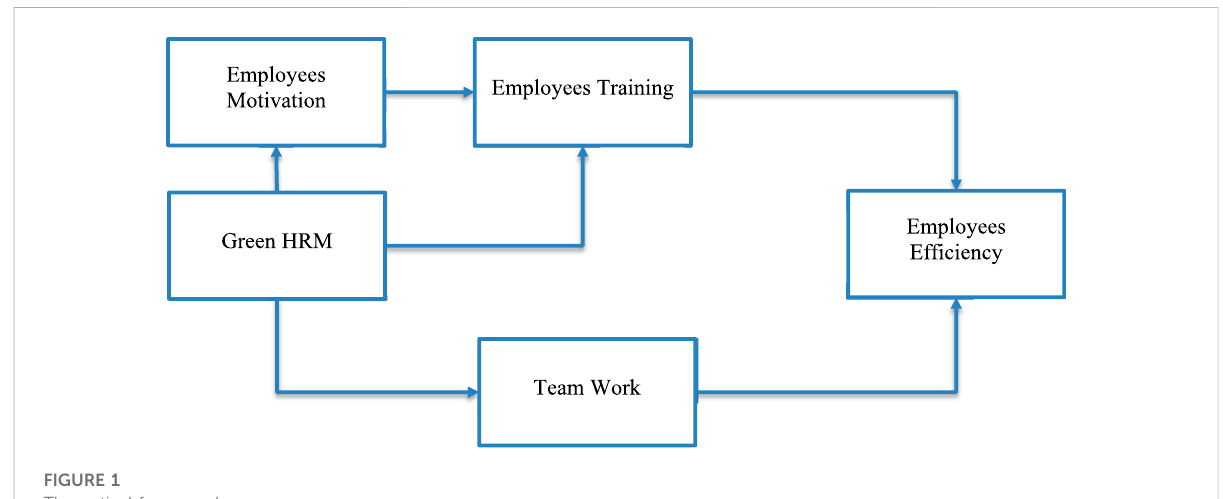
FIGURE 1 Theoretical